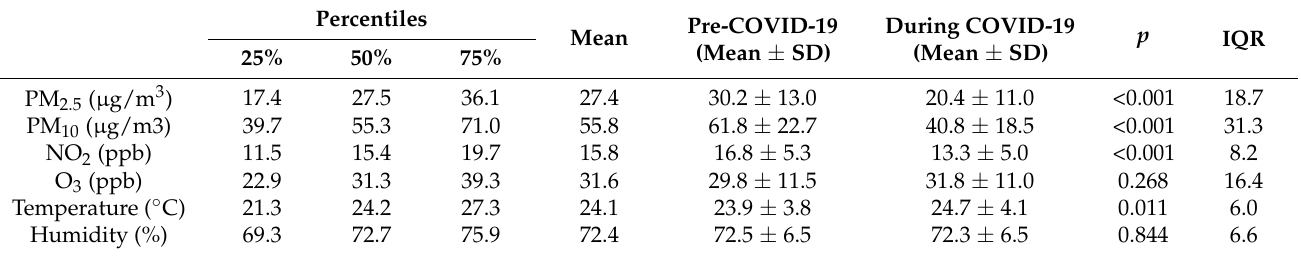
Table 2. Summary statistics of meteorological factors and air pollutants during the study period in Kaohsiung.